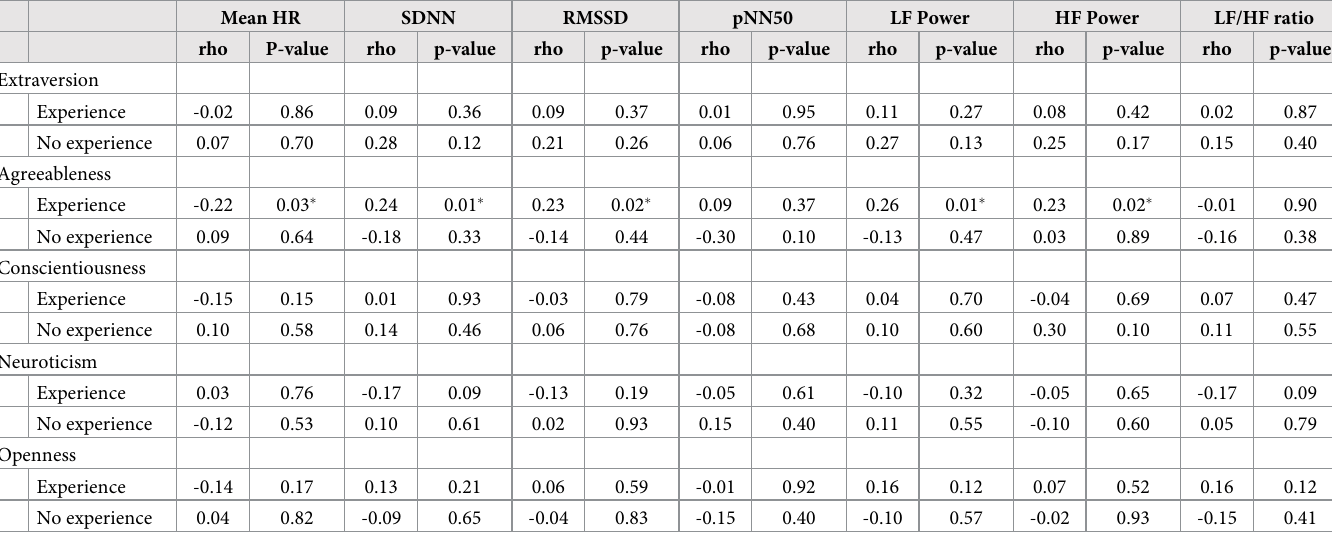
Table 5. Association between personality and HRV parameters according to the cardiac arrest